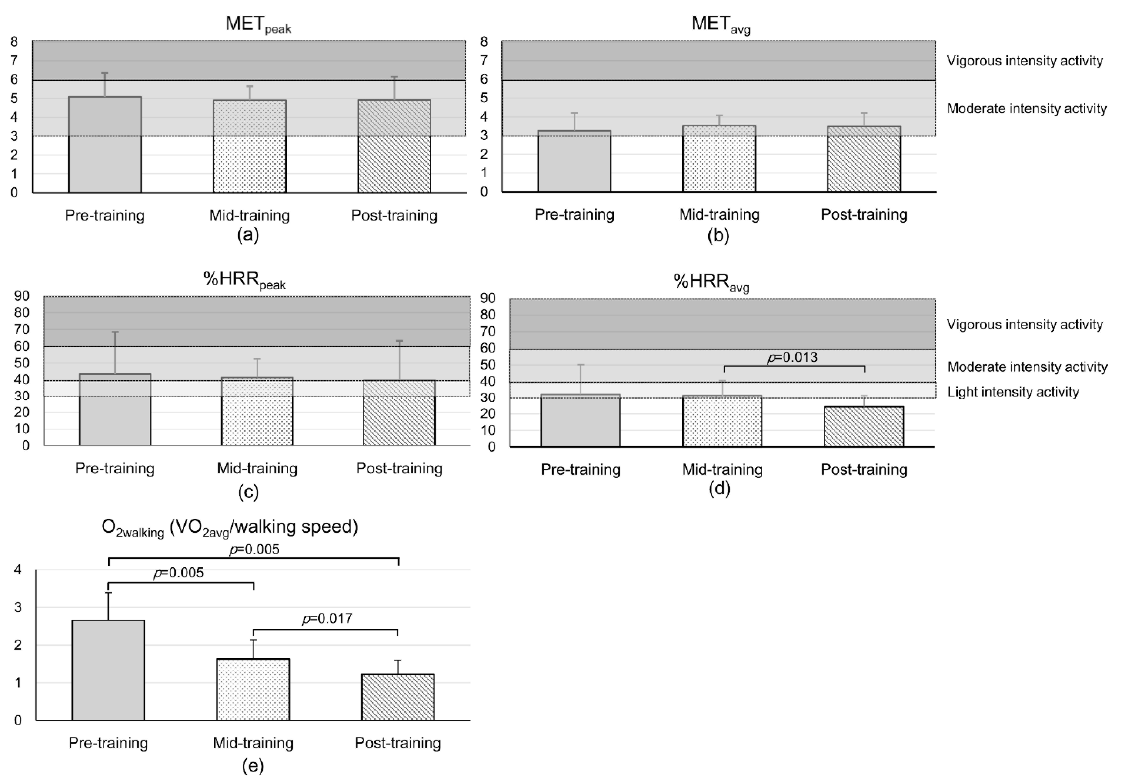
Figure 2. Changes in exercise intensity measured according to the ( a ) peak and ( b ) average (avg) metabolic equivalent of tasks (METs) for persons with spinal cord injury, ( c ) peak and ( d ) average heart rate relative to the heart rate reserve (%HRR), and ( e ) O 2 cost of walking measured using oxygen consumption (VO 2avg in mL/kg/min) divided by walking speed (m/min) (O 2walking ).